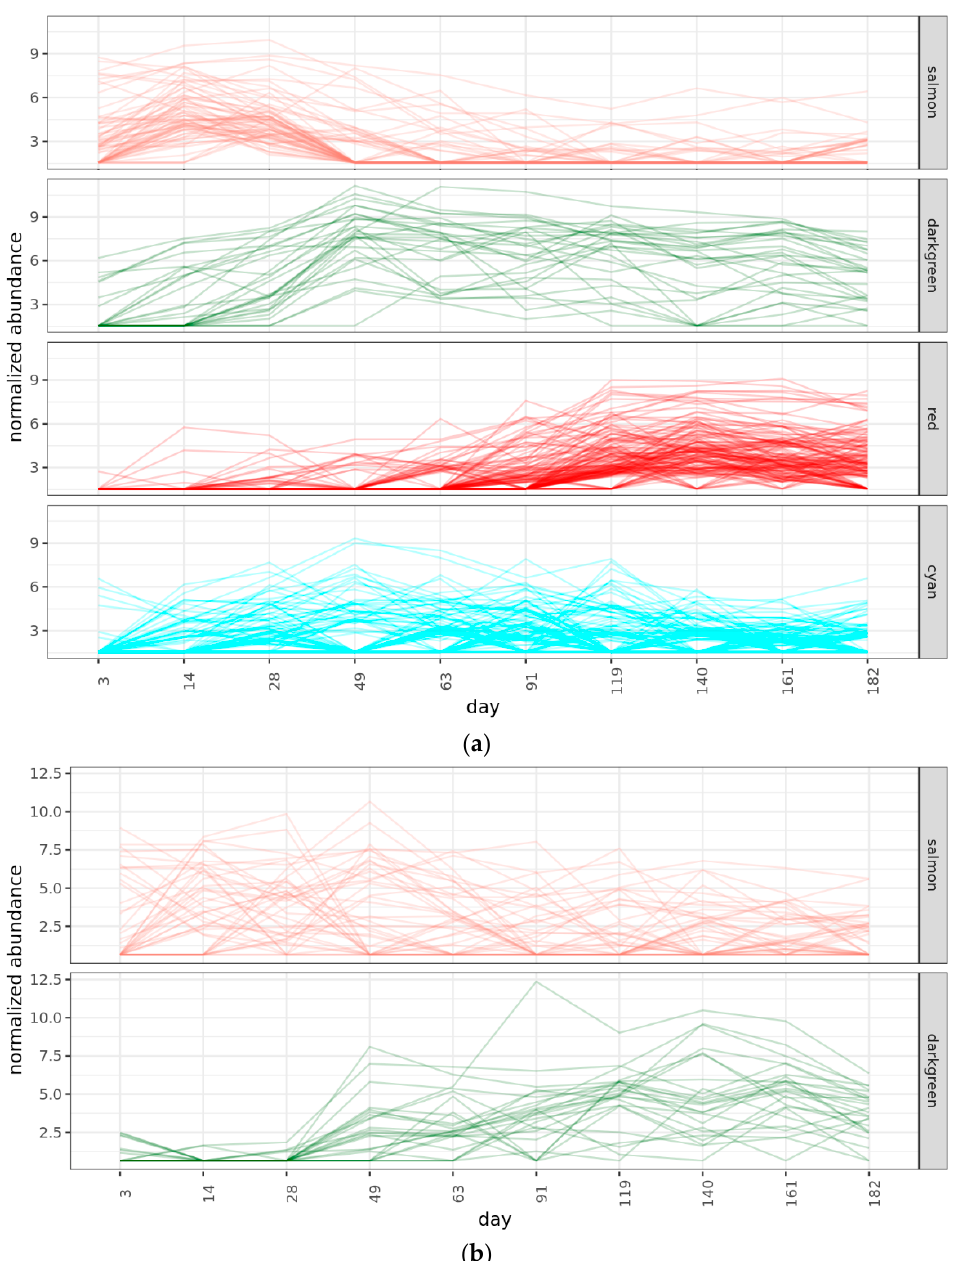
Figure 5. Clusters of co-changing groups of phylotypes for ( a ) prokaryotic and ( b ) fungal amplicon sequencing data, as assessed by WGCNA. ( a ) Early phase — salmon cluster, middle phase — green clyster, late phase — red cluster, universal — cyan cluster. ( b ) Early phase — salmon cluster, late phase — cyan clyster, universal — green cluster.